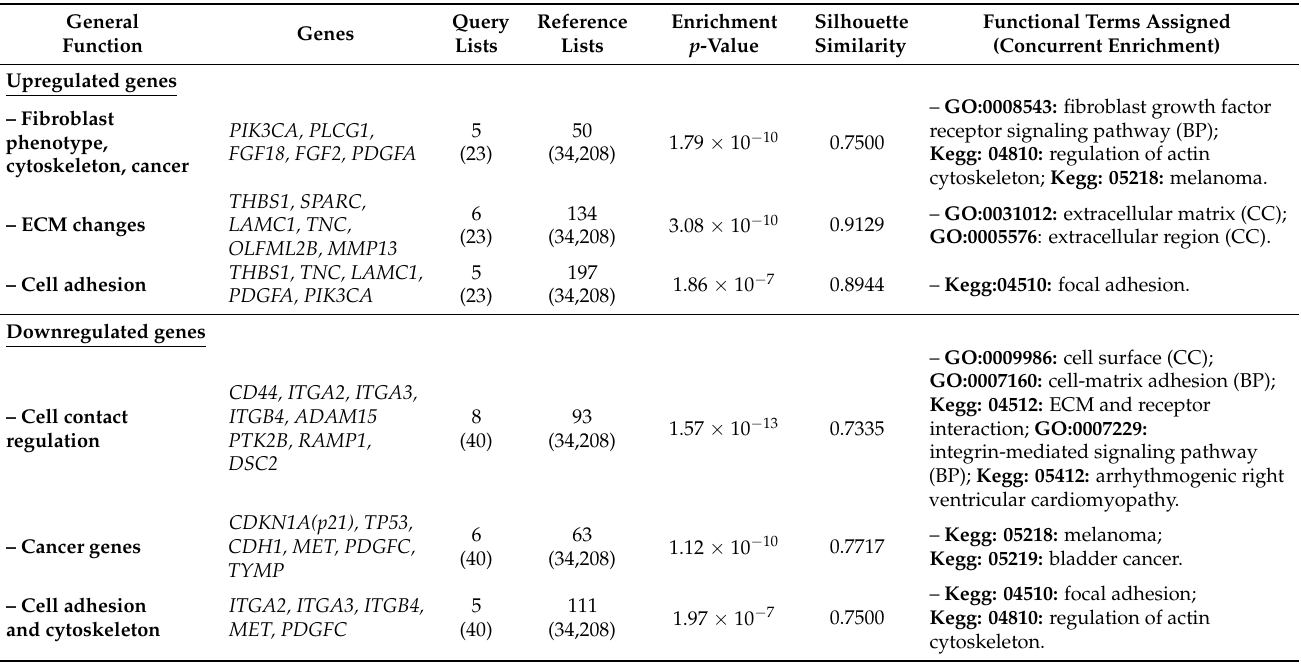
Table 2. Functional enrichment analysis of selected genes with concurrent